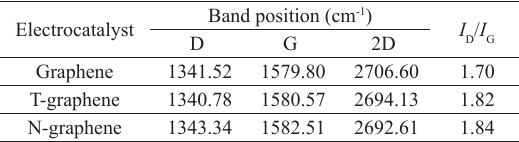
/ I ratios for the D G